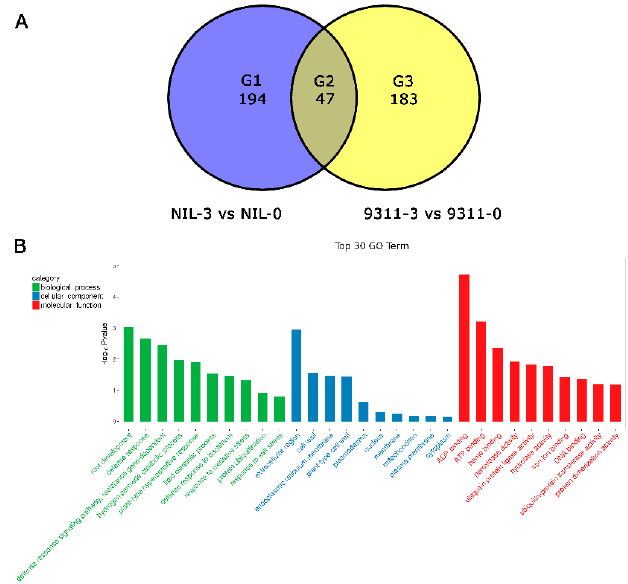
Figure 4. Gene ontology (GO) annotation of upregulated differentially expressed genes (DEGs): ( A ) Venn analysis of upregulated DEGs between NIL- Bph43 -9311 and 9311; ( B ) top 30 GO terms of specific upregulated DEGs in NIL- Bph43 -9311. 9311-0 and 9311-3 refer to 9311 sampled at 0 and 3 h of BPH infestation, respectively, and NIL-0 and NIL-3 refer to NIL- Bph43 -9311 plants sampled at 0 and 3 h of BPH infestation, respectively.